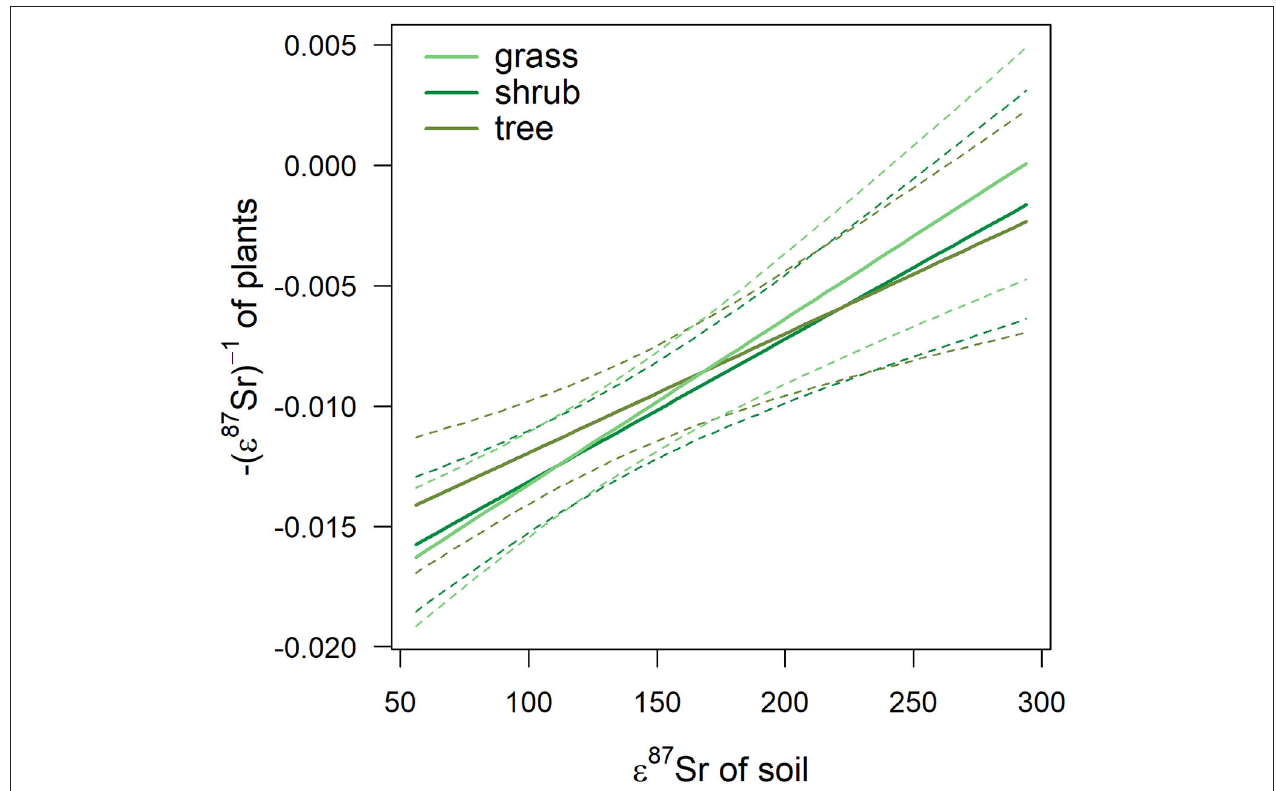
FIGURE 6 | Effect of 87 Sr/ 86 Sr values of soil, expressed in ε 87 Sr, on the 87 Sr/ 86 Sr values of plant, expressed in -( ε 87 Sr) − 1 , according to plant type. Fitted trends are presented with 95% CI (dashed